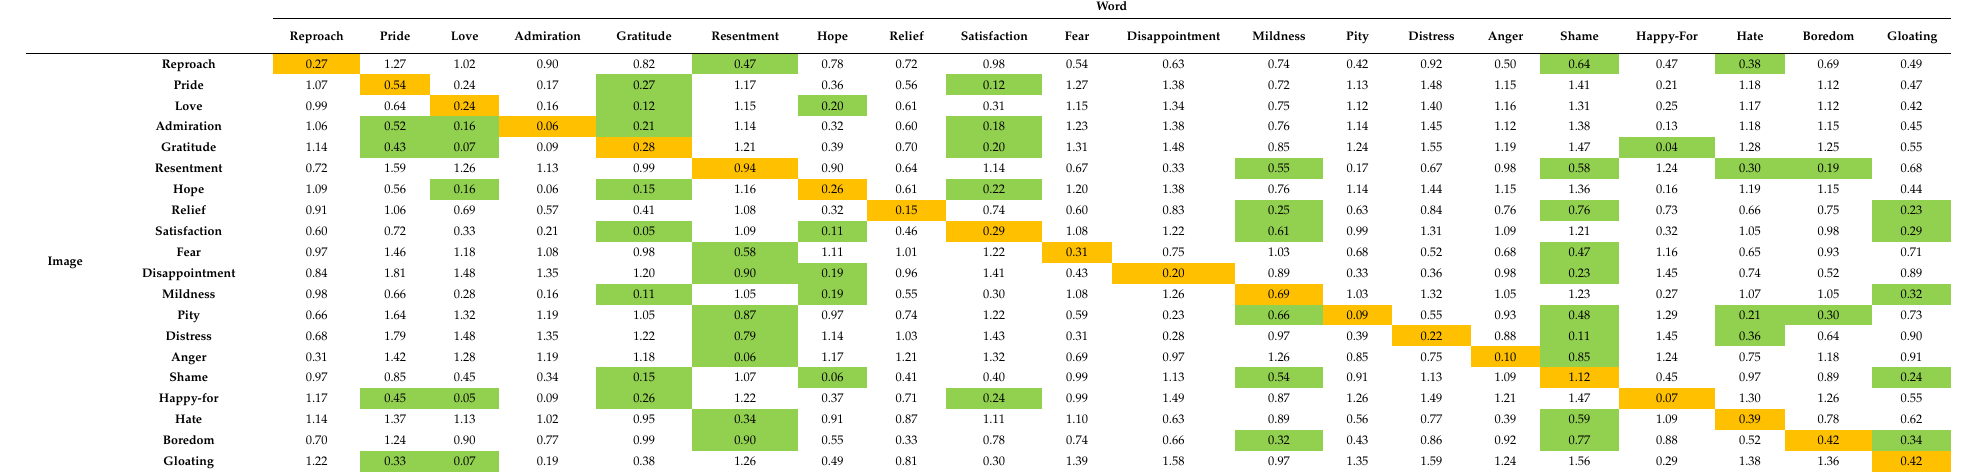
Table 2. The PAD Euclidean distance between 20 images and 20 emotional words in the pilot